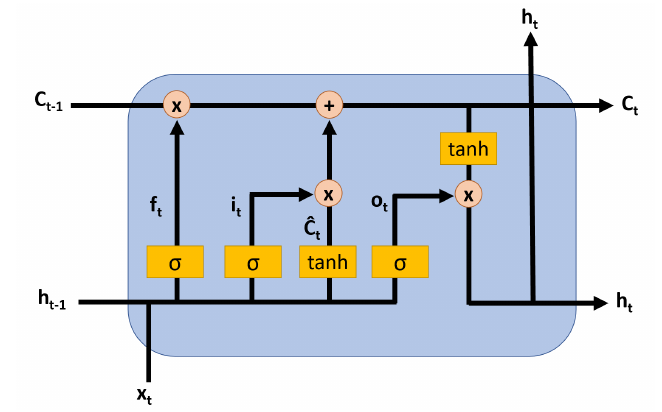
Figure 1. Structure of an LSTM memory